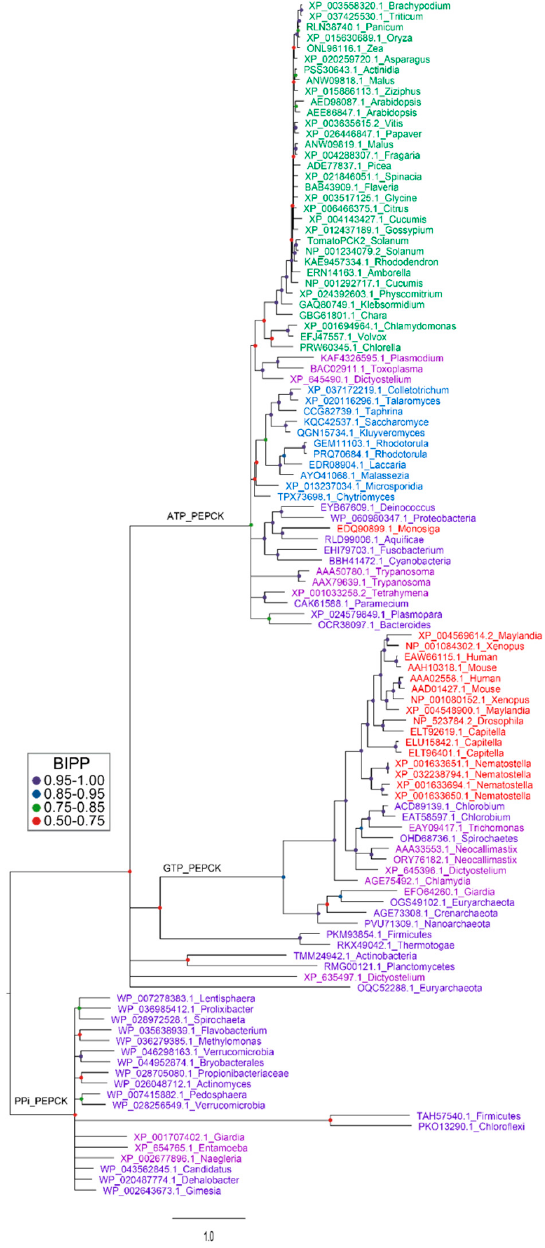
Figure 5. Phylogenetic analysis of PEPCK proteins from three domains of life. Several representative PEPCK protein sequences were selected for each phylum of three domains of life [130] including bacteria [131,132], protozoans and fungi [133], plants [134] and metazoans in the NCBI database. Protein sequences were aligned using Clustal W [135]. After deletion of segments with poor consensus alignment, sequences were subjected to Bayesian inference for establishment of phylogenetic relationships between proteins [136]. Analysis were run for 5 million generations under a mixed amino-acid model with rate variation between sites estimated by a gamma distribution. Bayesian inference posterior probabilities (BIPPs) of tree nodes are indicated by coloured dots. Gene identifiers of the proteins are color-coded to represent the phyla from which they are derived. Green for plants, blue for fungi, pink for protozoans, purple for bacteria and red for metazoans. Corresponding species names are listed by the side of accession number on each branch of the tree. Note for the plant species there are very little differences in the amino acid sequence of the protein apart from in the c12 kD N-terminal extension. Thus, the reconstructed phylogeny of the plant enzyme is based largely on this part of the protein.